Question: Condense the content of this figure into a single sentence.
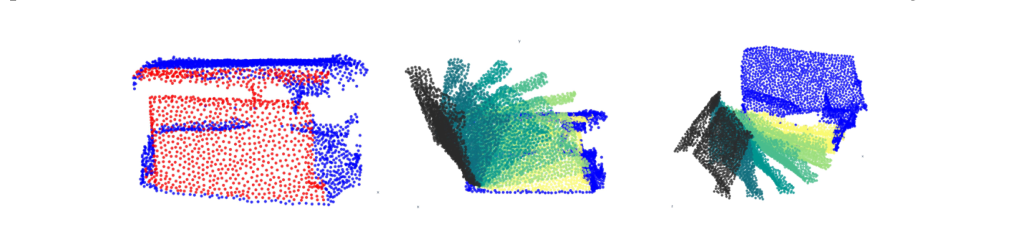
Answer: Failed FlowBot++ Prediction on a Microwave. Imperfect articulation parameter prediction caused the rotation to be off-axis.